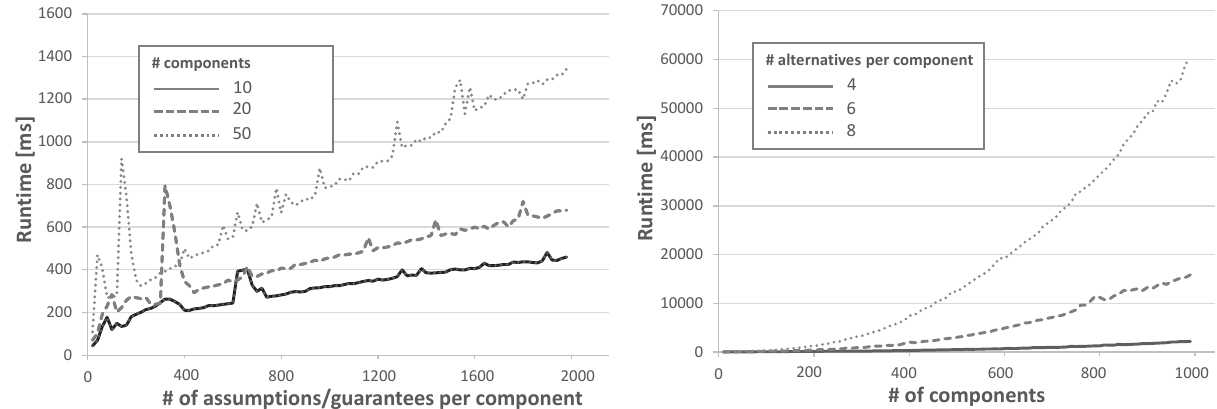
Fig. 7: Experimental results: runtime for system configuration with varying number of assumption/guarantee expressions and compo- nents (left) and varying number of components and alternative properties (right)